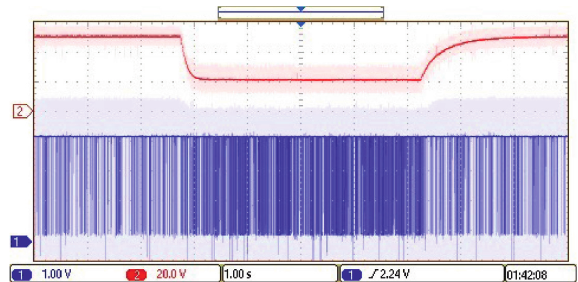
Figure 22: Output voltage (red) and FOSM controller signal (blue).